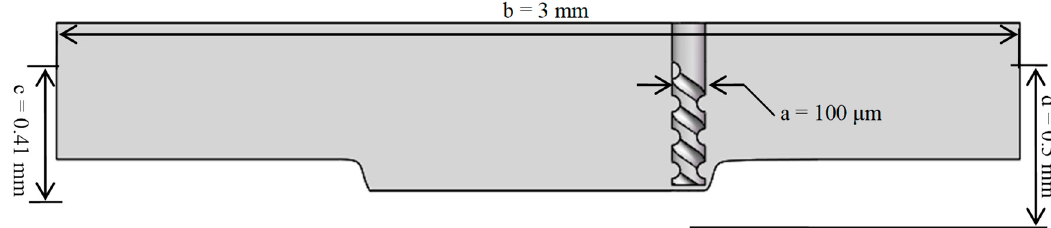
Figure 6. Flow field model of the machining gap.